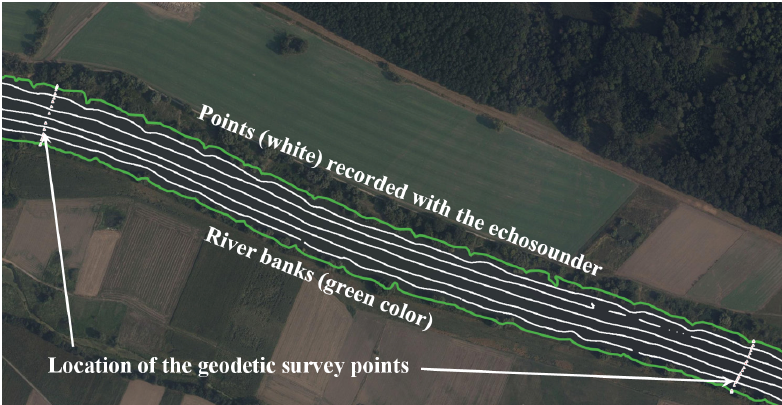
Figure 2. Aerial view of one small river reach showing the points that were recorded with the echo sounder